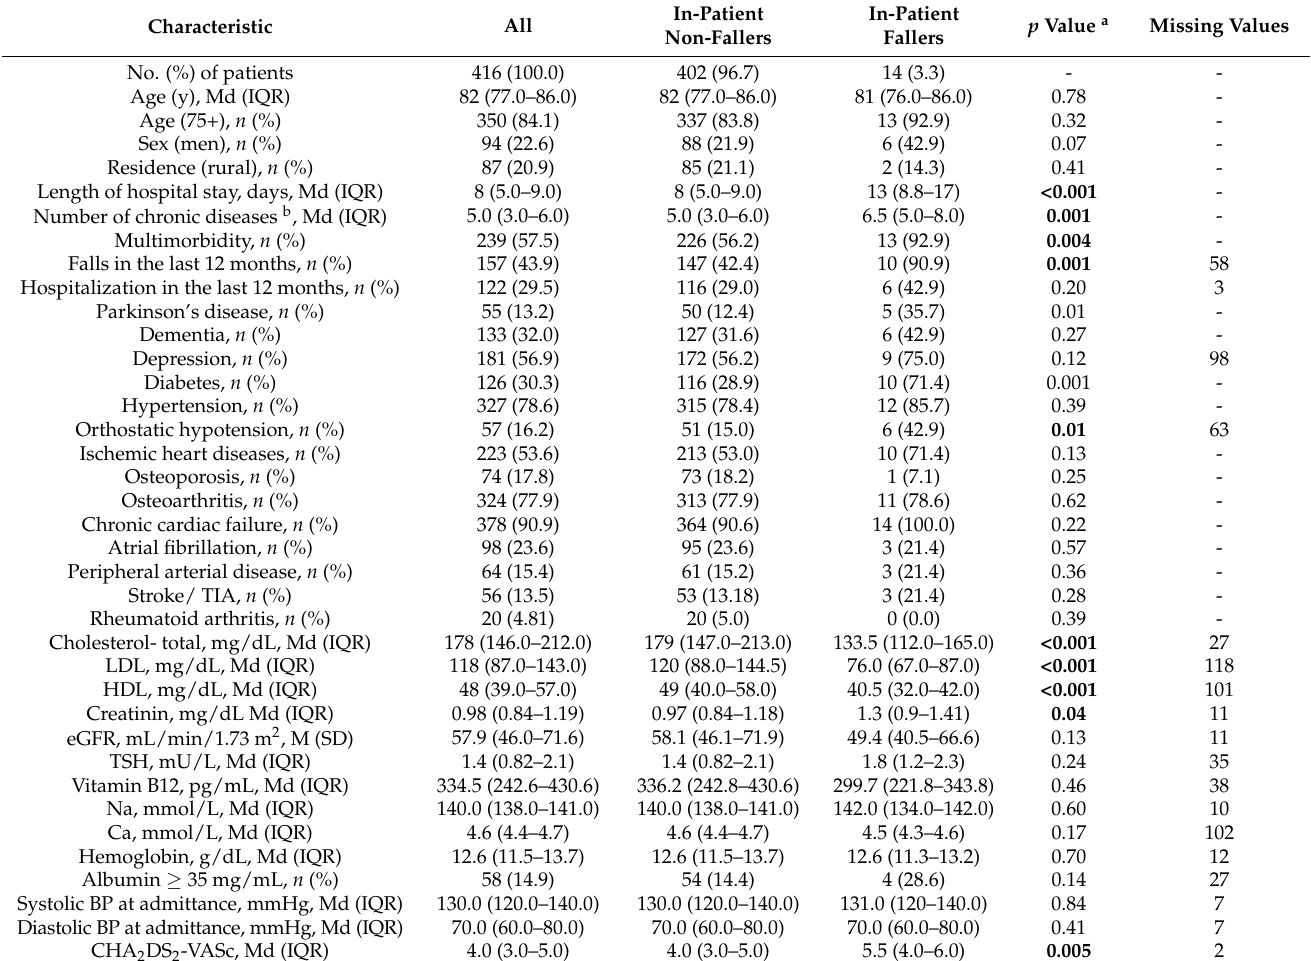
Table 1. Characteristics of study participants—sociodemographic and medical correlates of